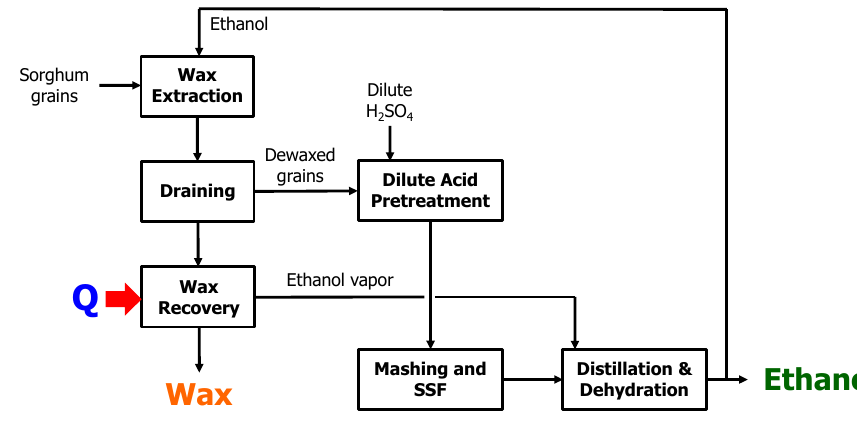
Figure 2. The integrated process for ethanol production from sorghum starch and fiber.